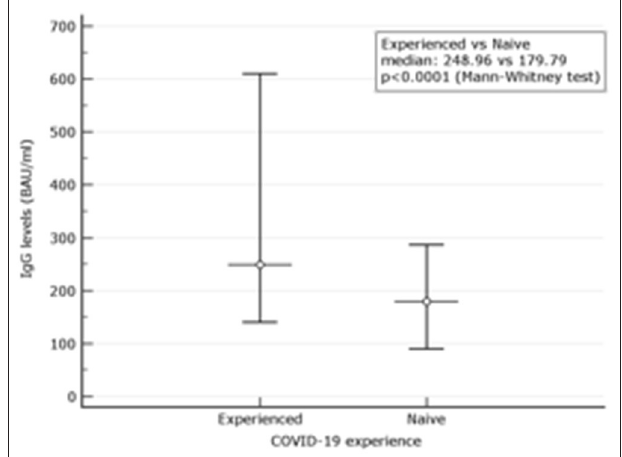
FIGURE 1 | Comparison between IgG levels in naive and experienced. Mean and Interquartile ranges ( IQR ) are reported ( p < 0.0001).